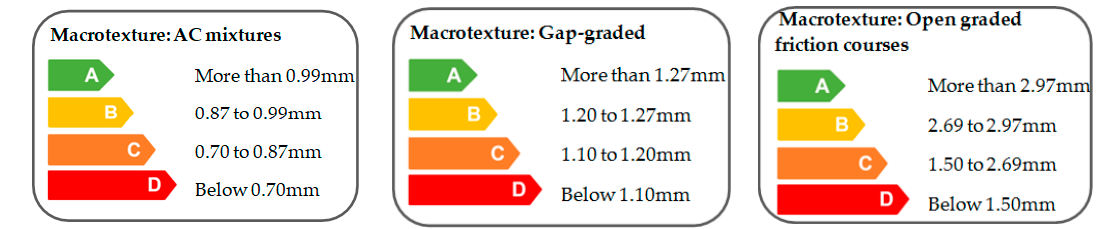
Figure 19. Macrotexture labels based on the type of mixture.